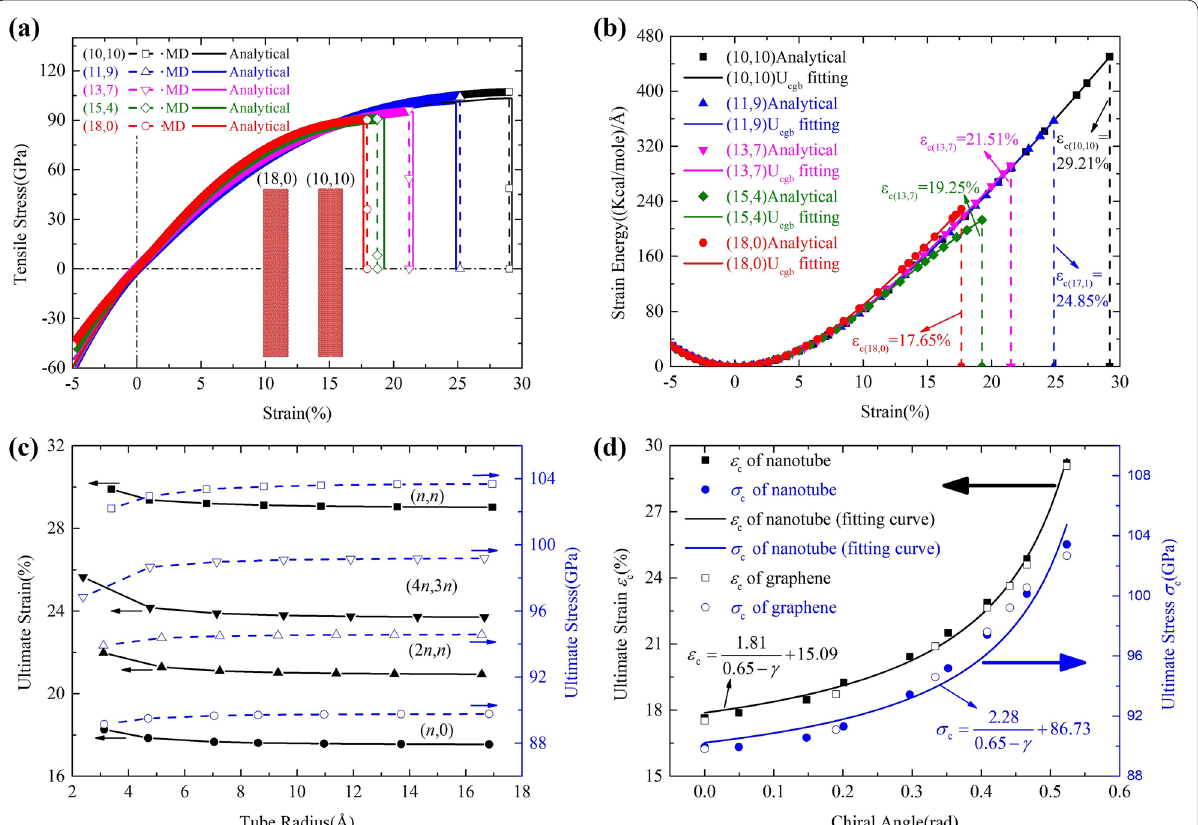
Figure 4 The mechanical properties of different chiral CNTs [61]: ( a ) The stress-strain curves of CNTs, ( b ) The strain energy vs strain curves per unit length of CNTs. The distribution of ultimate strains and stresses with ( c ) CNT radii for different chiral CNTs and ( d ) CNT chirality for a given CNT radius (around 6.8